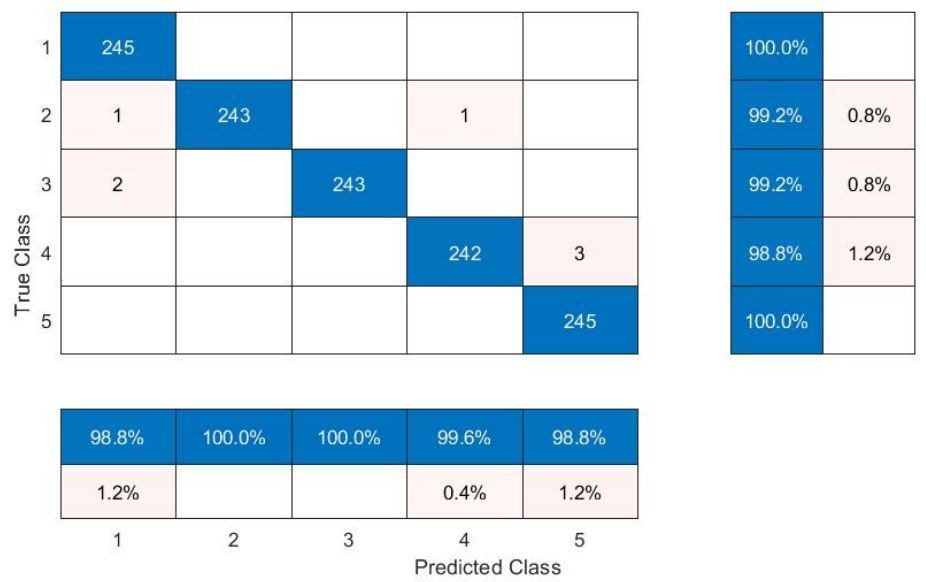
Figure 14. Confusion matrix: model trained at variable speed between 1000 and 2000 rpm and tested at variable speed between 3525 and 4125 rpm.